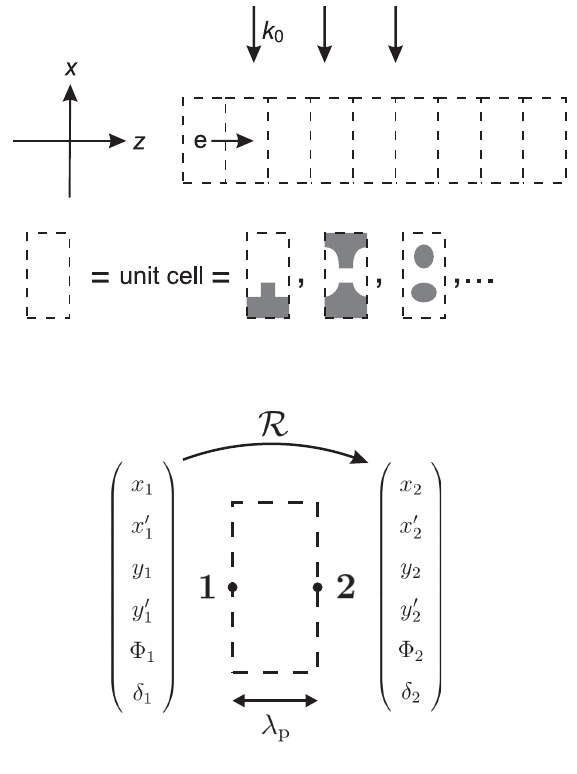
FIG. 2. A segment of a grating-type DLA. The unit cell is iterated in one dimension along the electron